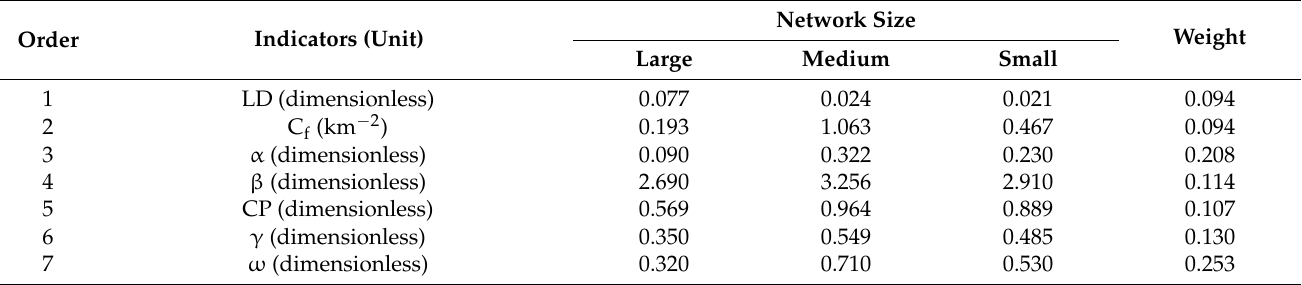
Table 11. Values and weights of the